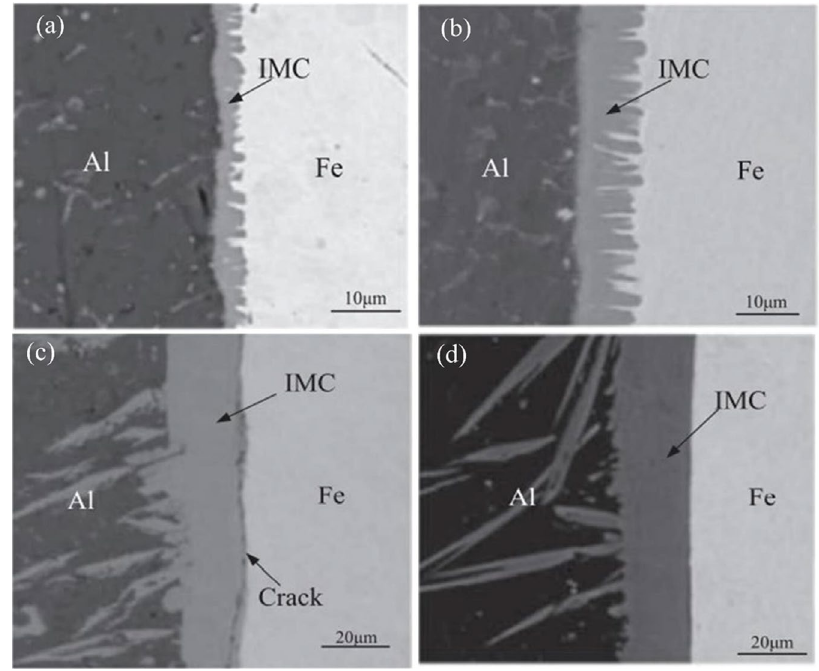
Figure 4. Effect of laser linear heat input on the IMC layer: ( a ) 1 kJ/cm, ( b ) 1.2 kJ/cm, ( c )1.5 kJ/cm, and ( d ) 1.7 kJ/cm.